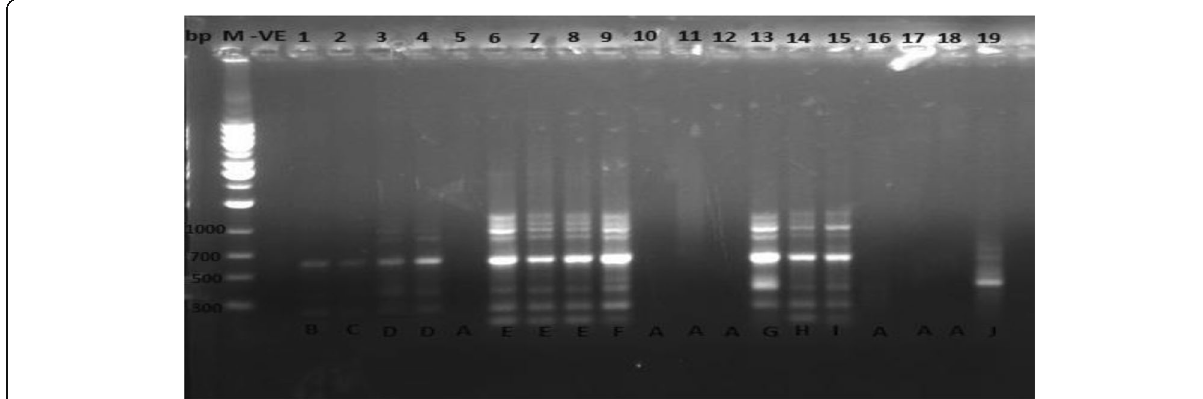
Fig. 3 RAPD agarose gel electrophoresis with OPC 05 (5 ′– GAT GAC CGC C-3 ′ ) primer. Same alphabet indicates identical banding pattern. A, Non- type-able DNA; − VE, Negative control; bp, Base pairs; M, 1 kb DNA molecular marker. 1, FARO-44 (control); 2, FARO-52 (control); 3, FARO-57 (control); 4, NERICA L-34 (control); 5, NERICA L-47 (control); 6, FARO-44 (0% NaN 3 ); 7, FARO-44 (0.004% NaN 3 ); 8, FARO-44 (0.016% NaN 3 ); 9, FARO- 52 (0.004%